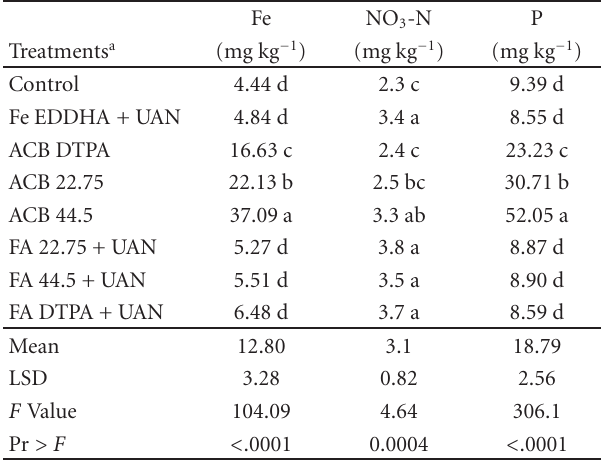
Table 2: Soil NO 3 -N, P, and Fe a Doak sandy loam after amending with Fe EDDHA +UAN (urea ammonium nitrate), fly ash+ UAN, and composted biosolids ( n = 8 per treatment). Means with the same letter are not significantly di ff erent at α = 0 . 05